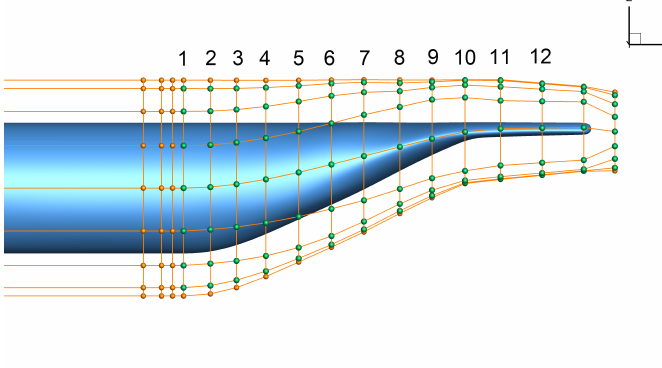
Figure 11. The military transport aircraft monitor